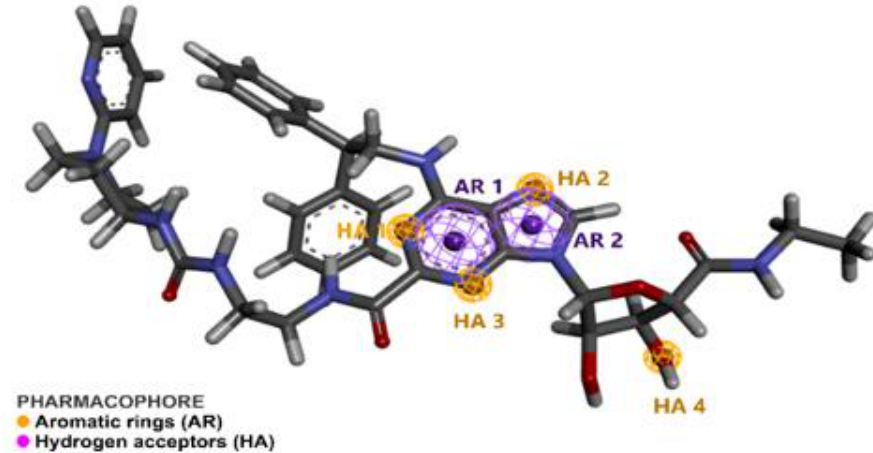
Table 1. Coordinates and radius of the spatial features of the selected pharmacophore model.